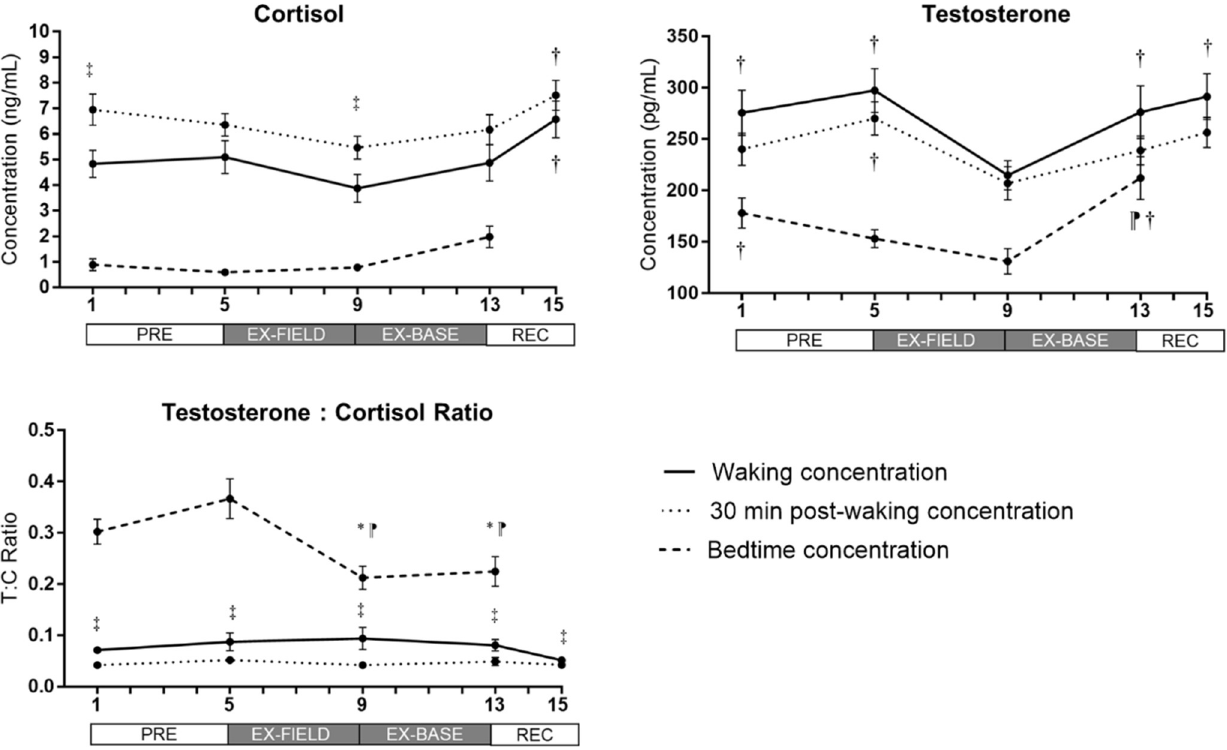
Fig 2. Mean ( ± SEM) changes in concentrations of salivary cortisol and testosterone, and testosterone/cortisol ratio (T:C ratio) during 16-day study period, including PRE (baseline), EX-FIELD (field training assessment exercise), EX-BASE (simulated base exercise), and REC (recovery period). � p < 0.05 vs day 1; ⁋ p < 0.05 vs day 5; † p < 0.05 vs day 9; ‡ p < 0.05 between conditions (waking vs 30 min